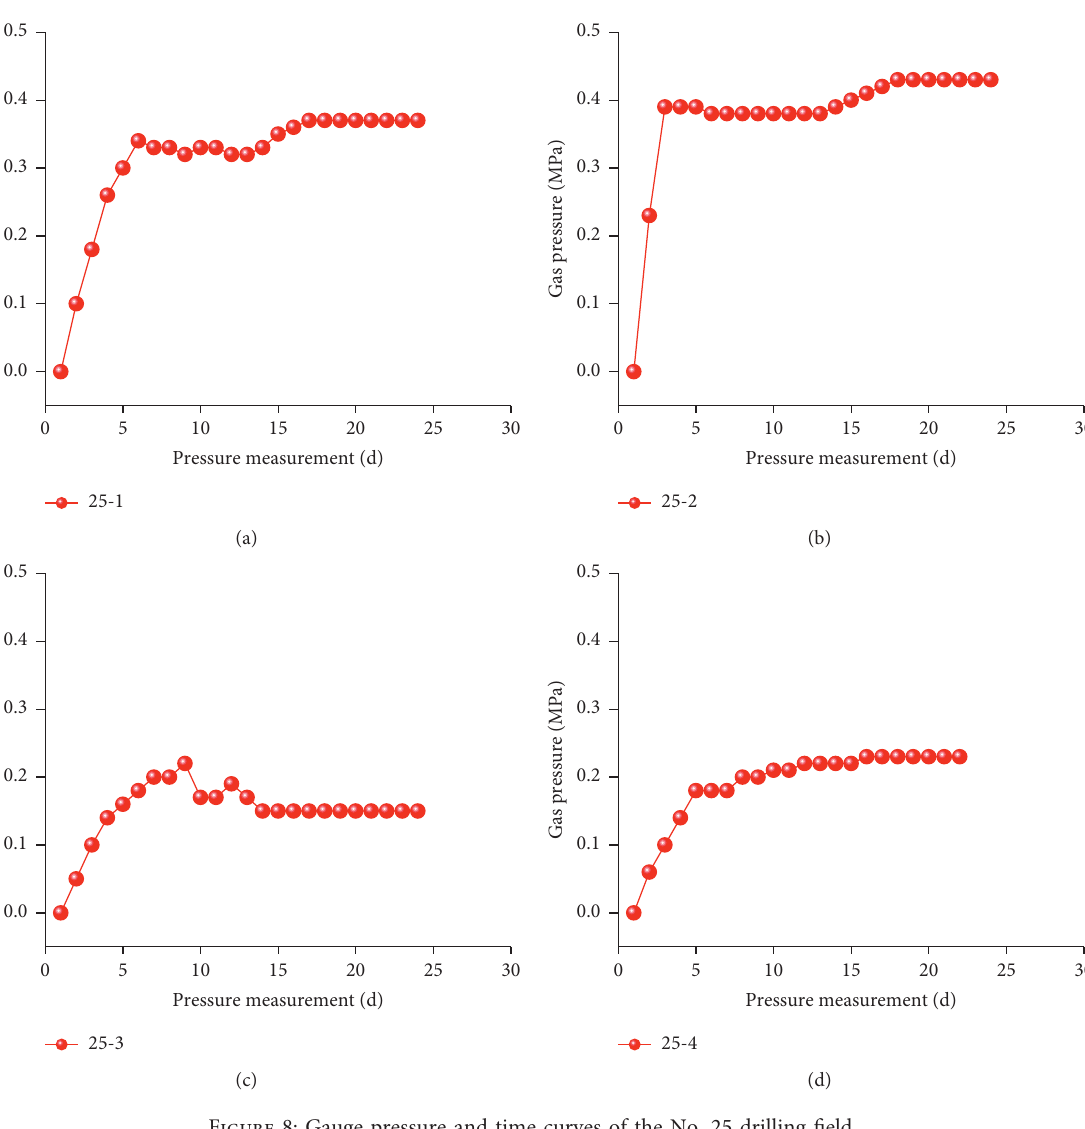
Figure 8: Gauge pressure and time curves of the No. 25 drilling field.